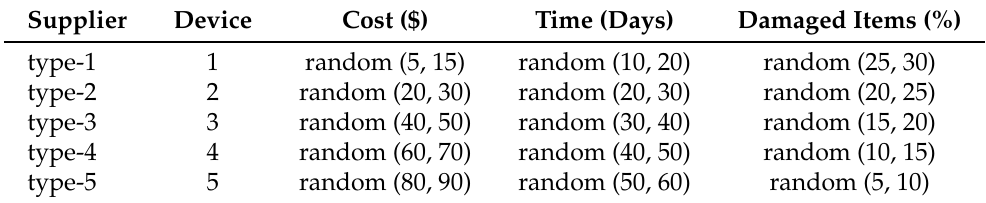
Table 3. Specification of providers’ data for five different devices